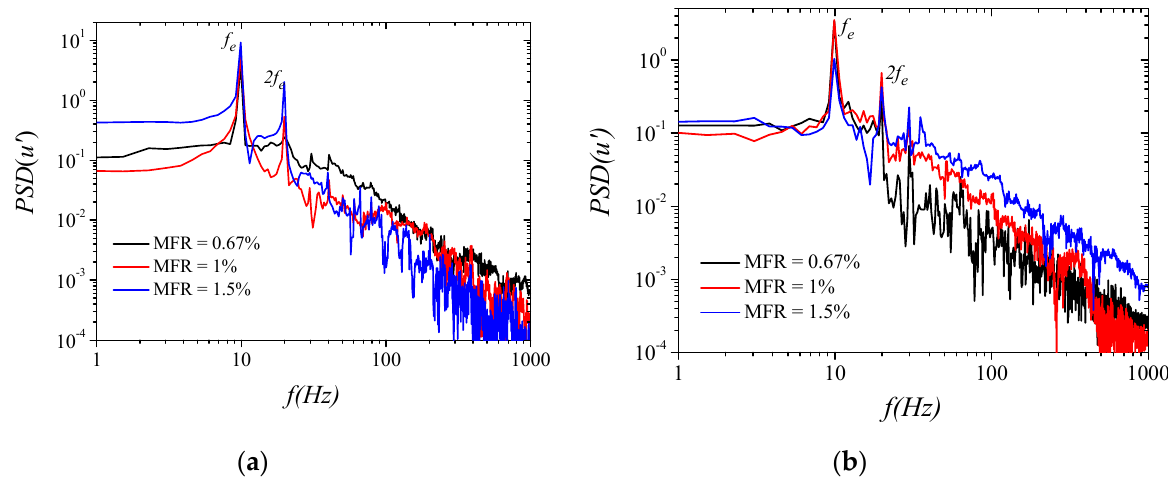
Figure 16. PSD of the velocity fluctuation in the shear layer. ( a ) x / D = 2, ( b ) x / D =